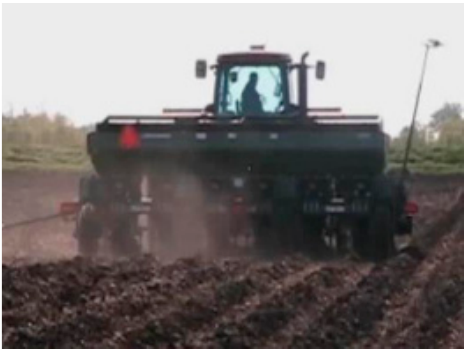
Figure 17. Lockwood 506 series potato planter. Reprinted with permission from ref. [48] Copyright 2018 Lockwood Industries.